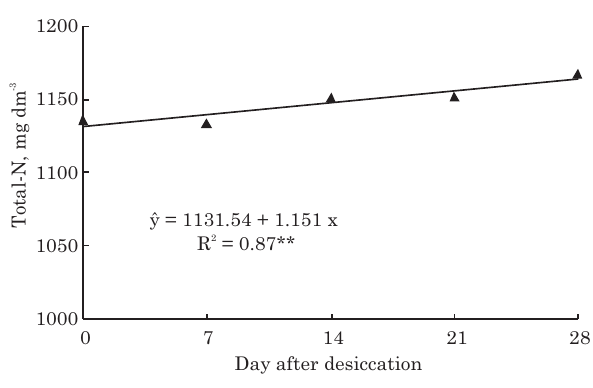
Figure 2. Total nitrogen (Total-N) in the soil as a function of time after the desiccation of Brachiaria sp. with glyphosate (mean of rhizosphere and non- rhizosphere soil of four brachiaria species). ** significant by the F test at 1 %.